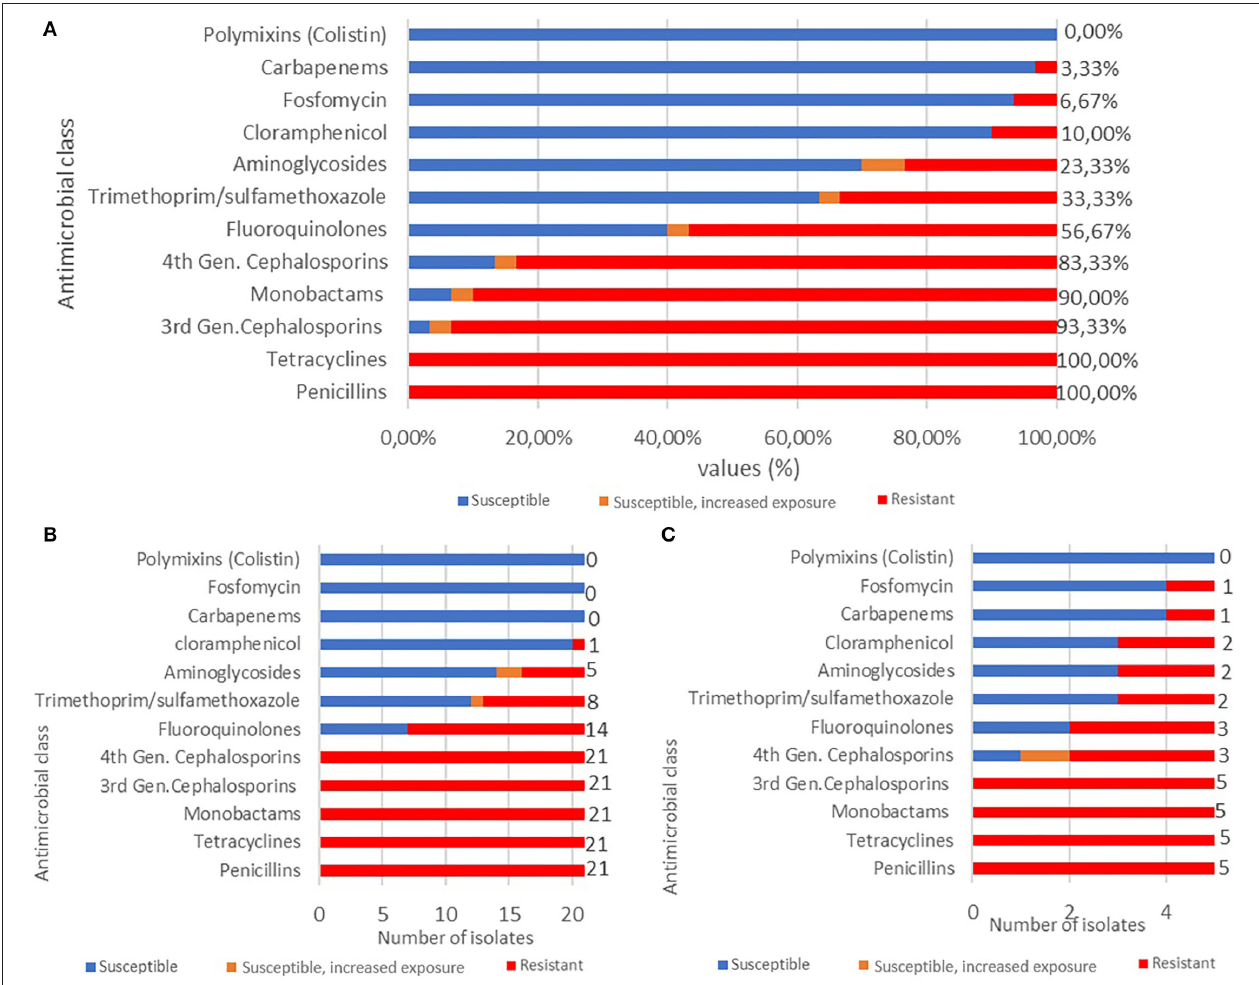
FIGURE 6 | (A) Antimicrobial resistance profile of Enterobacterales ( n = 30) isolates to 10 different antimicrobial classes. (B) Antimicrobial resistance profile of MDR E. coli ( n = 21) isolates to 10 antimicrobial classes. (C) Antimicrobial resistance profile of Klebsiella spp. ( n = 5) isolates 10 antimicrobial classes.